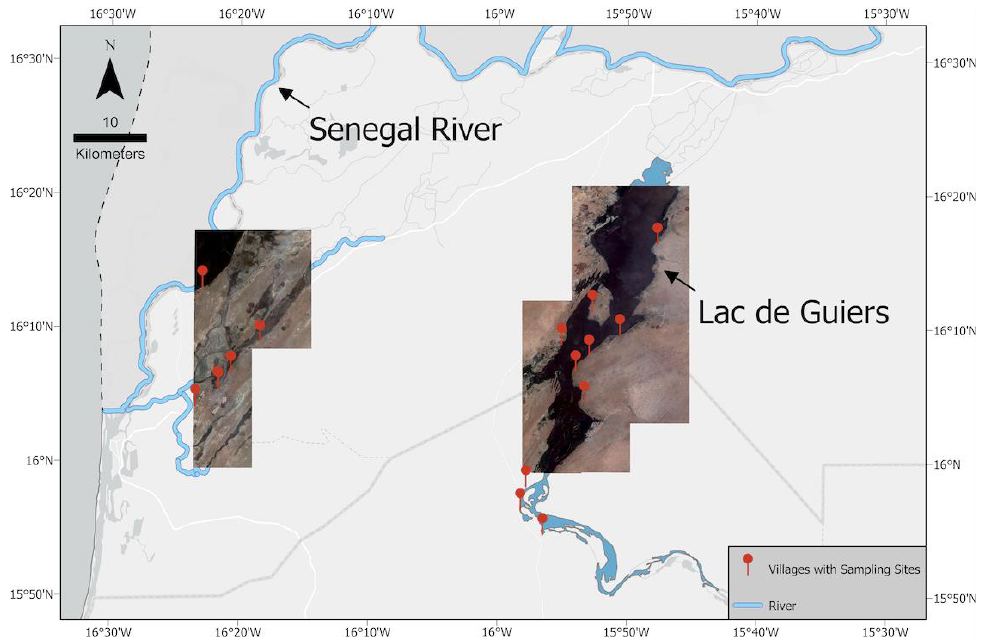
Figure 3. A mosaic of Maxar Technologies Inc., Westminster, CO, USA (formerly DigitalGlobe) WorldView-2 imagery of our study area, the SRB. Red markers indicate the locations of our 32 sam- pling sites.